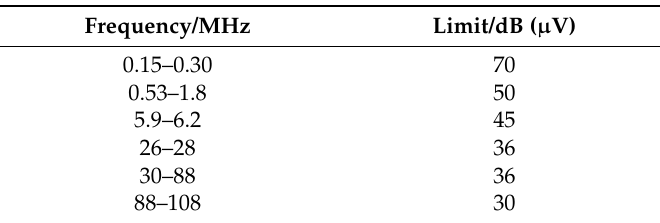
Figure 3. The measurement for conducted-EMI emission. Table 1. CISPR25 class3-average limits for conducted voltage.